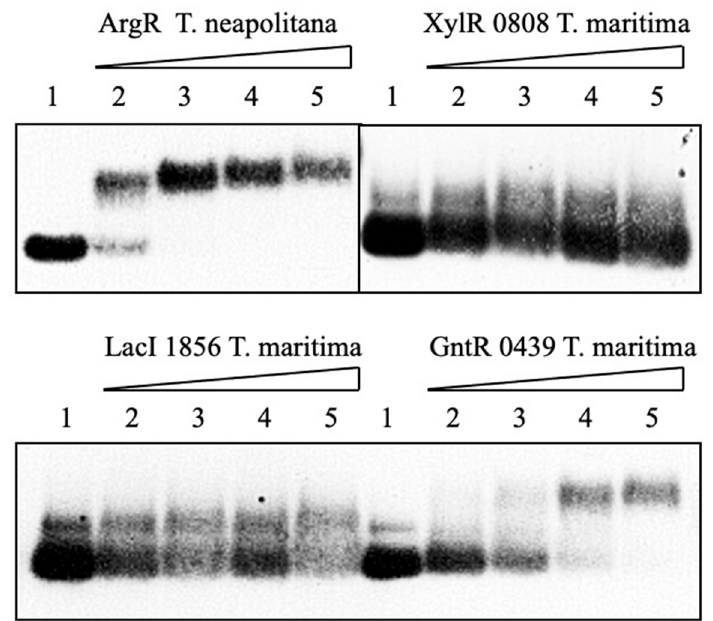
Figure 6. Gel-shift analysis of T. neapolitana and E. coli DNA operator regions binding to cell-free synthesized T. neapolitana ArgR and T. maritima putative regulatory proteins. Lane 1—without